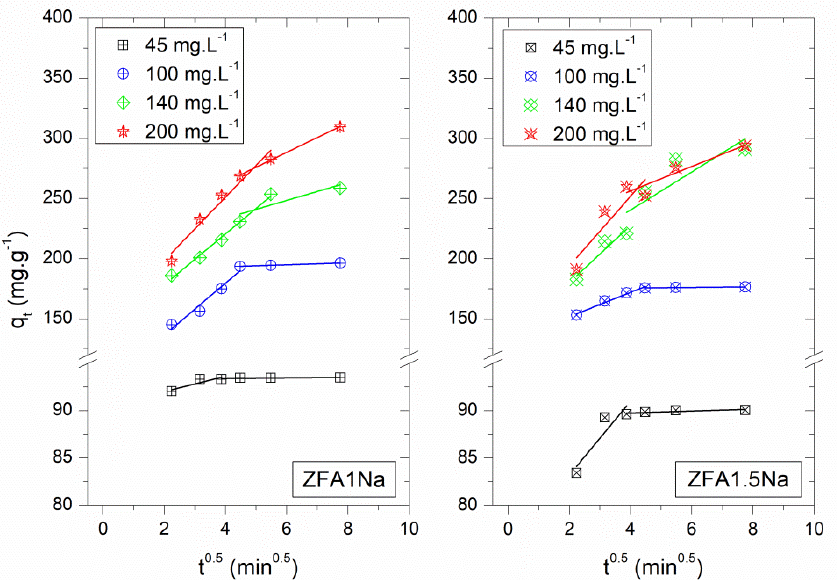
Figure 7. Intraparticle diffusion model for copper removal onto ZFA1Na and ZFA1.5Na zeolites.